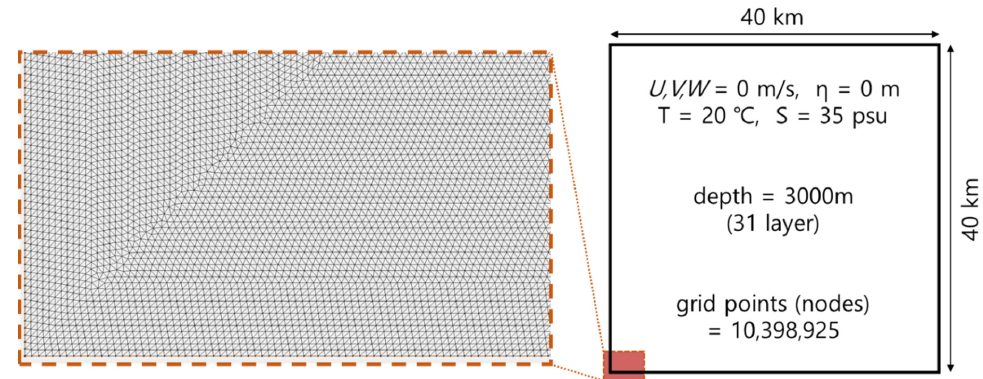
Figure 15. Enlarged unstructured triangular grids (left) and the experimental configuration (right) for